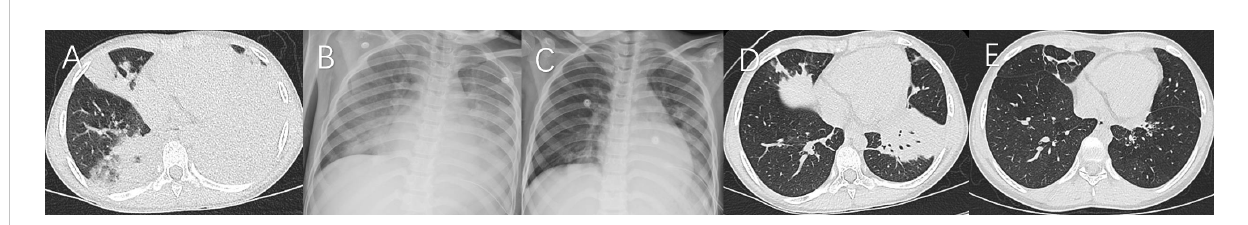
FIGURE 3 Case 3. Chest imaging showed bilateral/unilateral high-density lesions ( A , day 6; B , day 11; C , day 16; D , day 21), and string-atelectasis and slight enlargement of bronchial lumen ( E , 11 months after illness